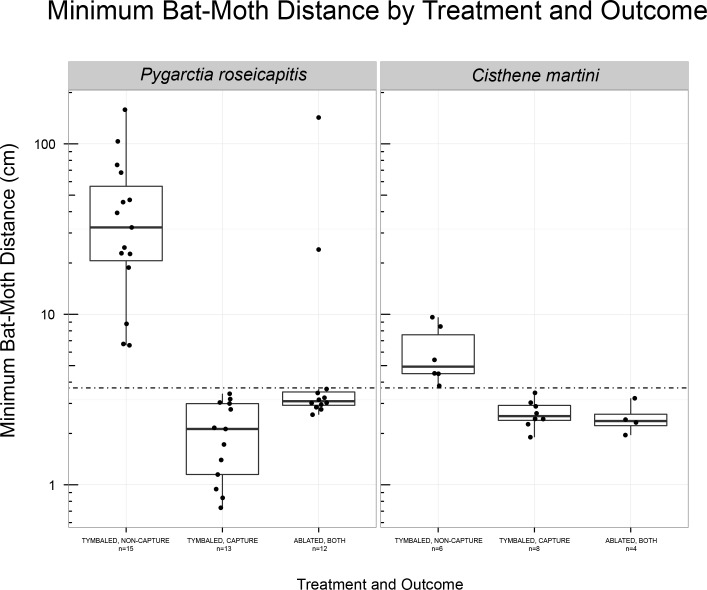
Minimum bat-moth distances (mBMD) between “Capture, Drop” and “Non-Captured” outcomes among “Tymbaled” (T+ and S groups) and “Ablated” (T-) moths for Pygarctia roseicapitis and Cisthene martini.Boxplot follows plotting conventions in Fig 3. Horizontal dot-dashed line demarcates 3.7 cm which was the most conservative of the smallest minimum bat-moth distances in which we could measure due to inherent limitations and error in the 3-D reconstruction process. Bat and moth should be considered to be occupying the same coordinates below this value. This plot displays the closest distance between bats and moths (T+ and S treatments) during each interaction. Interactions that resulted in “Capture, Drop” were all below 3.7 cm. All interactions that resulted in “Non-Capture” were above 3.7 cm.